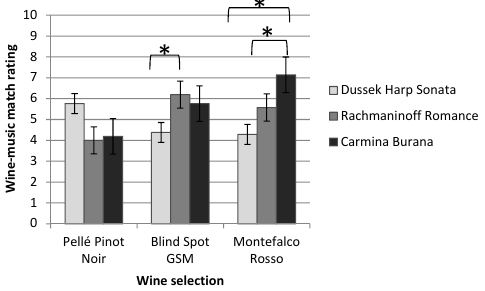
Figure 1. Mean wine–music match scores for all wine–music combinations, on a scale of 0 (does not match at all) to 10 (very good match). The error bars represent the standard error of means. * represents statistical significance at p = 0.05.